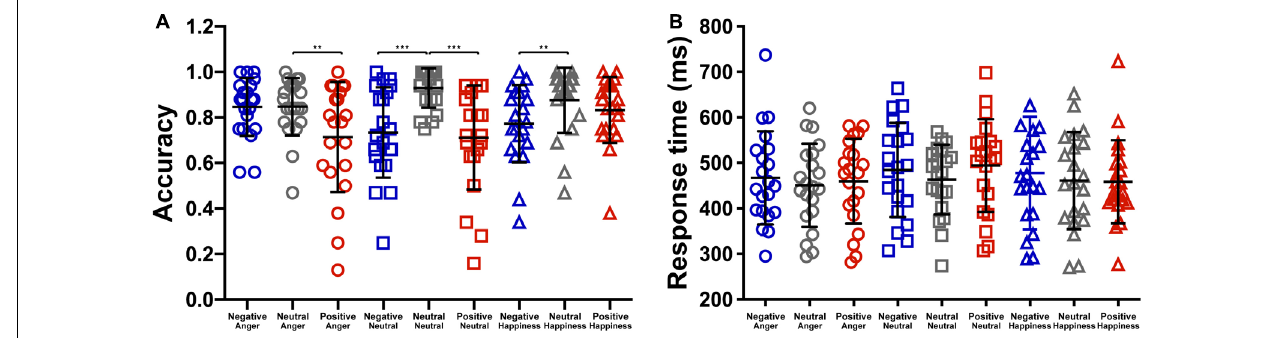
FIGURE 2 | The effect of context on the (A) accuracy and the (B) response time (*** p < 0.001, ** p < 0.01).